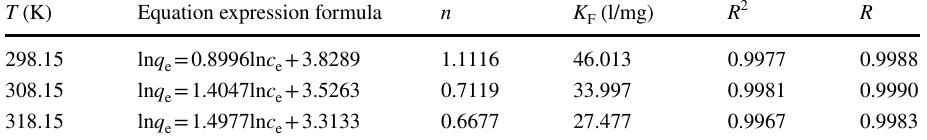
Table 3 Freundlich adsorption isotherm equation data